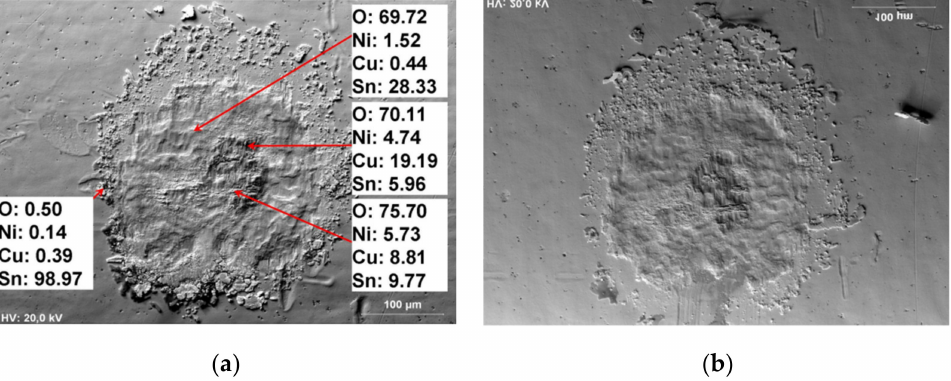
Figure 2. Fretting scars as seen in an SEM micrograph obtained after 2600 fretting cycles in a CuSn/Ni/Sn contact material system: ( a ) lower sample ( b ) upper sample